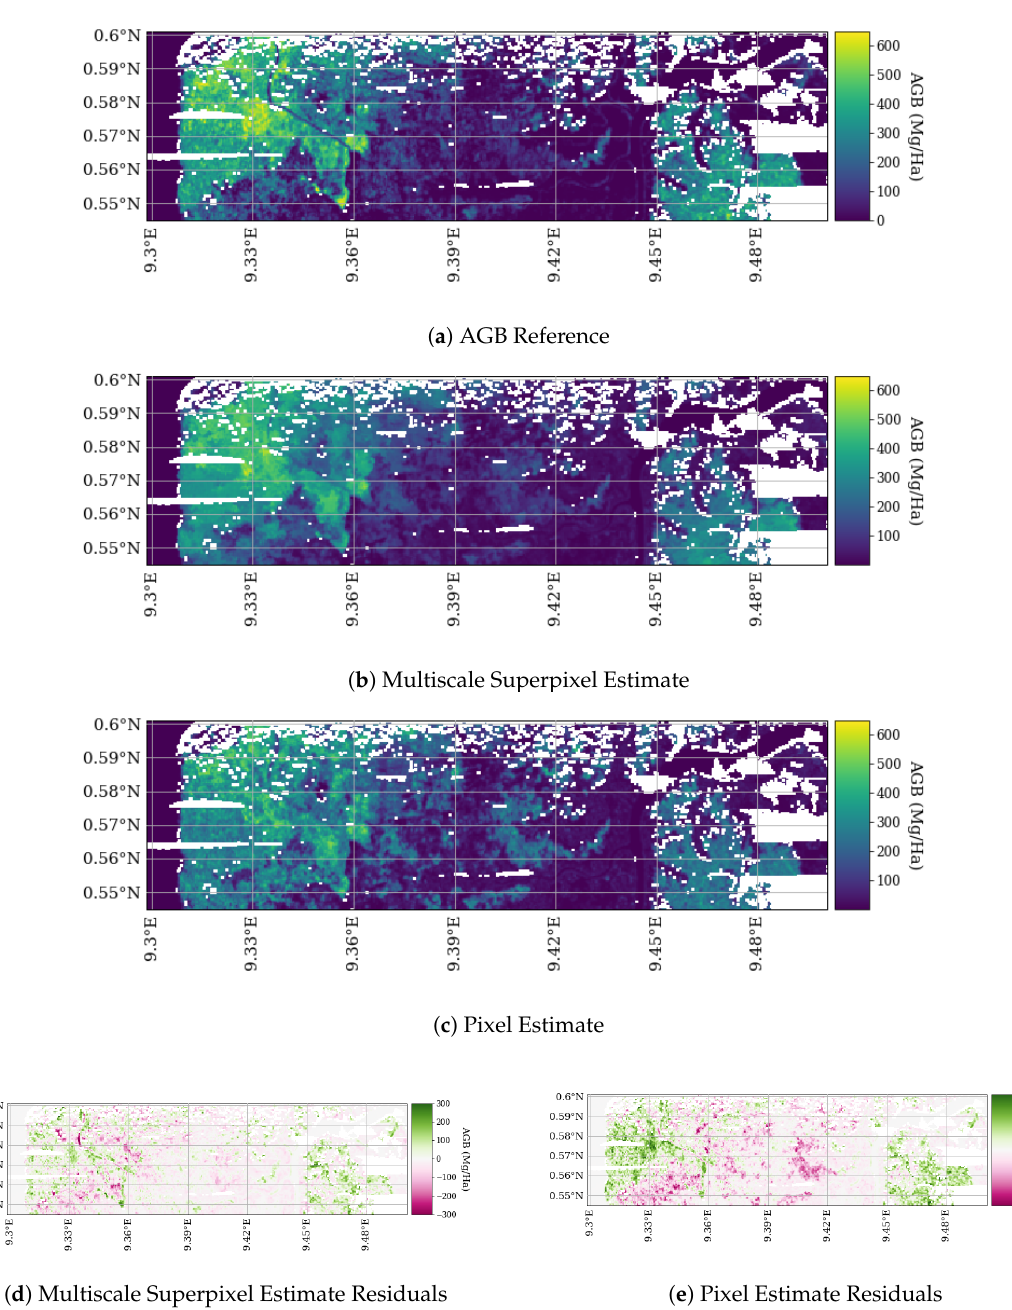
Figure 10. Comparing the AGB reference map shown in ( a ) with those derived from multiscale superpixels shown in ( b ) and with those derived from pixels shown in ( c ) on a subset of Mondah. Residuals are shown in bottom row. Model is trained on and applied to full AGB range. ( d ) Multiscale Superpixel Estimate Residuals; ( e ) Pixel Estimate